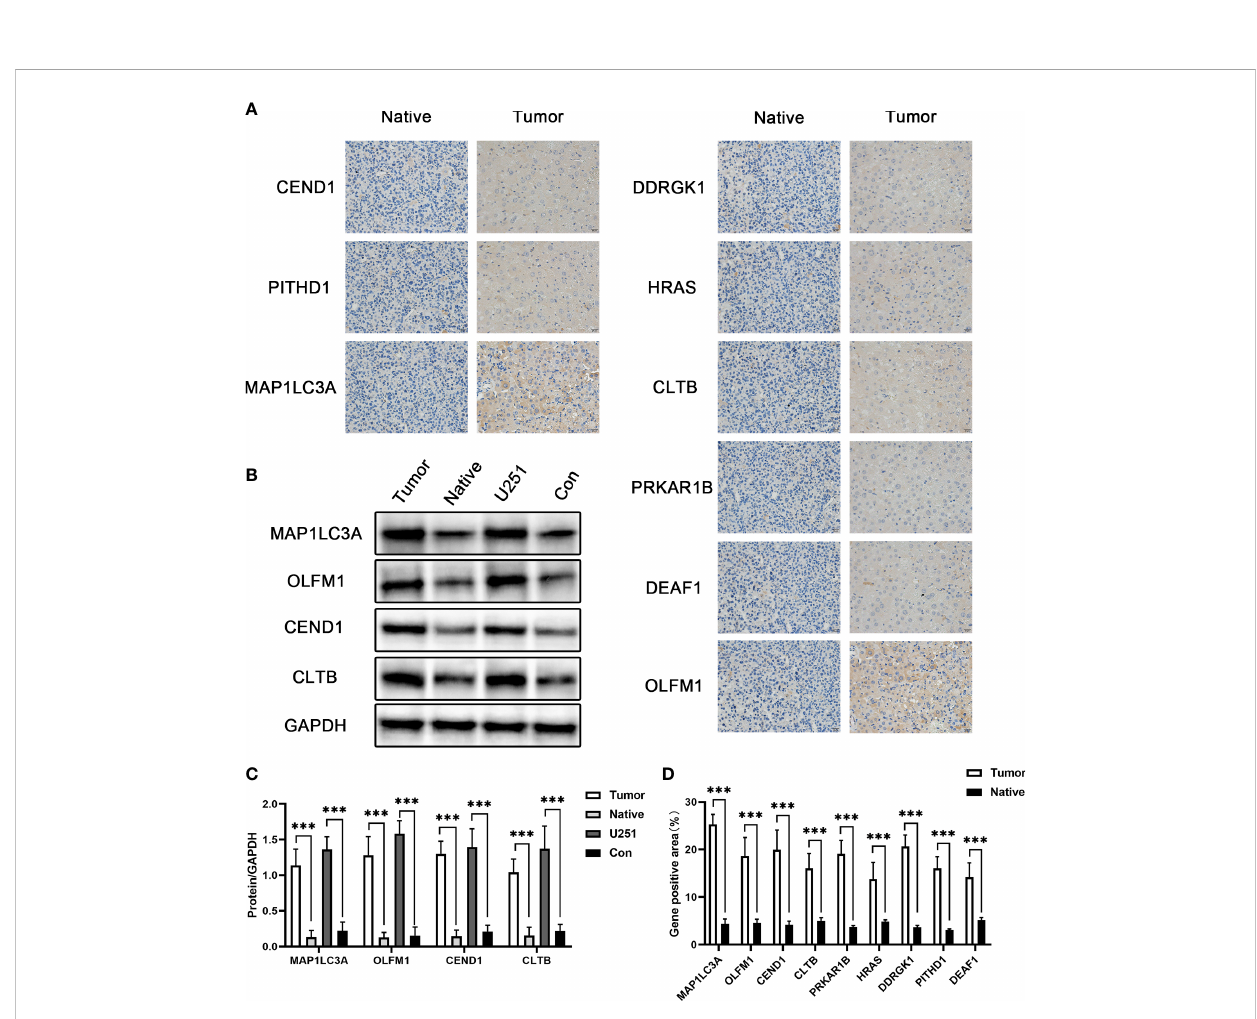
FIGURE 5 The expression of potential biomarkers. (A) Immunohistochemical detection of MAP1LC3A, OLFM1, CEND1, CLTB, PRKAR1B, HRAS, DDRGK1, PITHD1, and DEAF1 gene expression. (B) Western blot detection of the MAP1LC3A, OLFM1, CEND1, and CLTB protein expression levels. (C) Quantitative results of Western blotting. (D) Quantitative results of immunohistochemistry. *** means p value less than